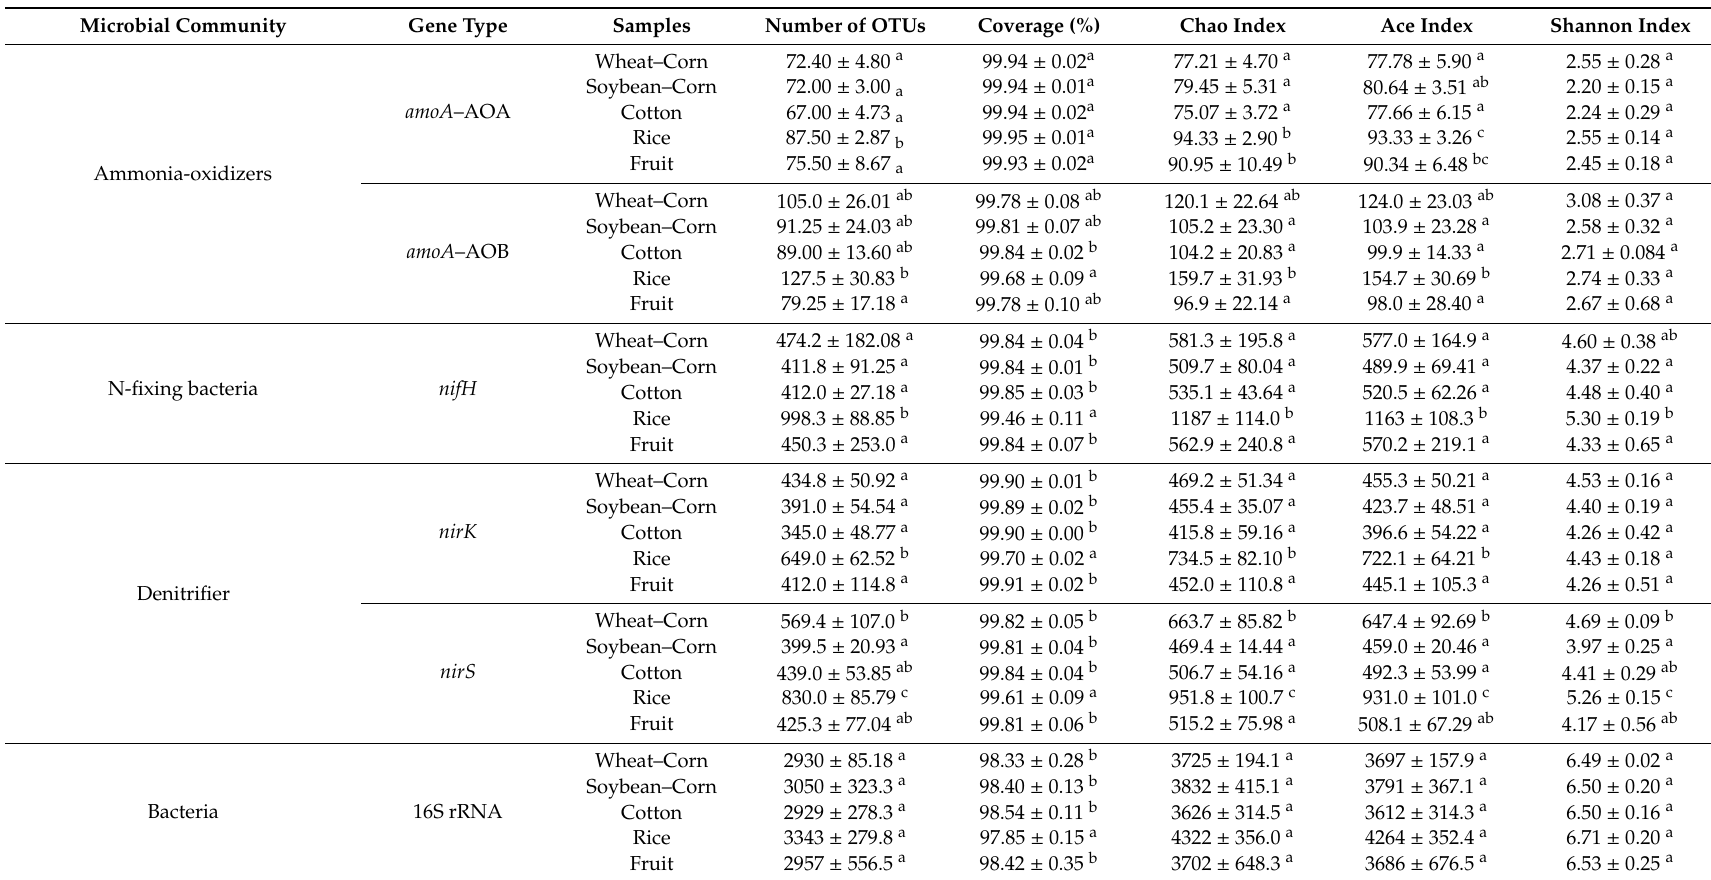
Table 3. Microbial richness indices of the samples from di ff erent agroecosystems. Microbial